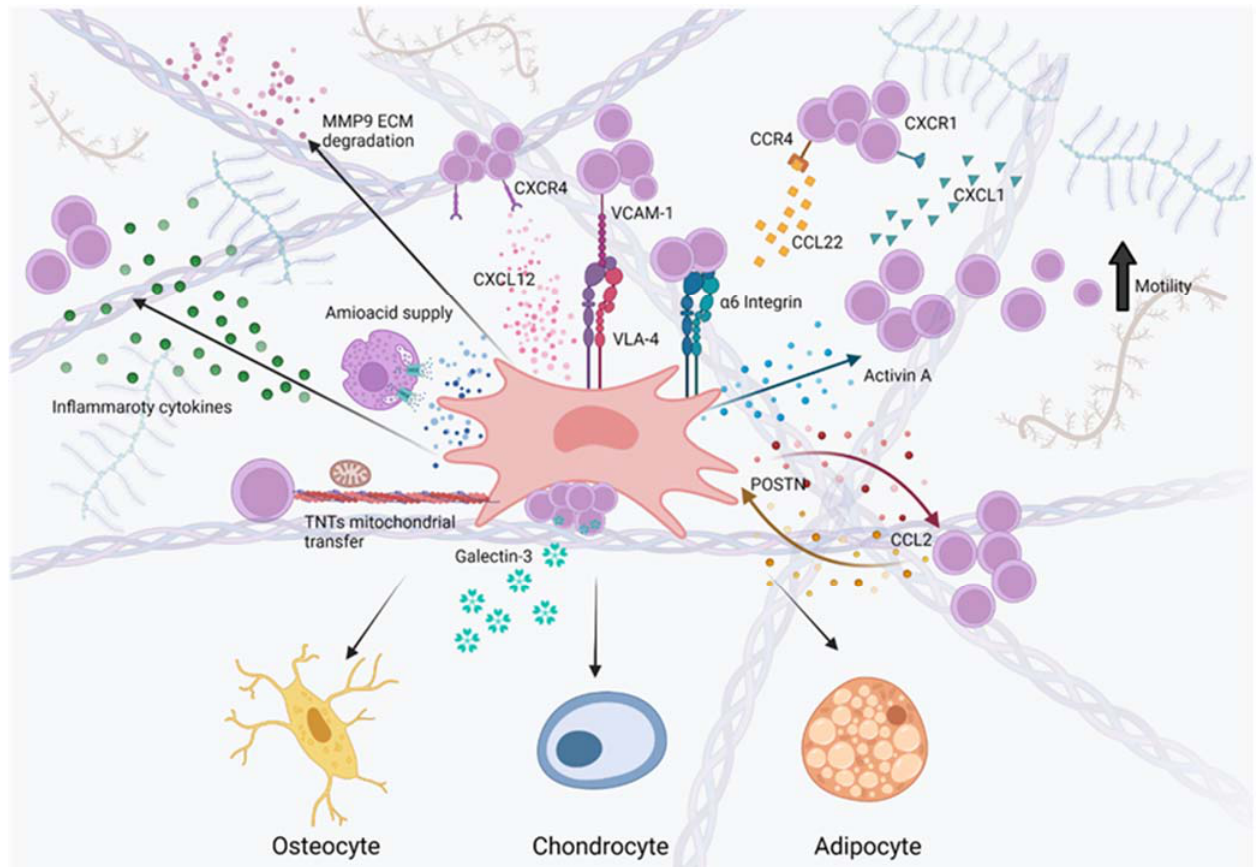
Figure 1. Role of mesenchymal stromal cells (MSCs) within the leukemic bone marrow (BM) niche. MSCs and their progeny including osteocyte/osteoblasts, adipocyte and chondrocyte (bottom) are key elements of B-cell acute lymphoblastic leukemia (B-ALL) BM niche. They interact through different mechanisms with leukemic cells protecting them from chemotherapy and providing signals that promote their survival and proliferation. Within the leukemic niche, MSCs secrete high levels of Activin A potentially promoting the migration of B-ALL cells to extramedullary sites (right, light blue dots). In turn, the high levels of Activin A downmodulate the production of CXCL12, possibly causing the displacement of healthy hematopoiesis in favor of leukemic cells. Other chemokine axes important for leukemia progression are represented by CXCR1/CXCL1 (blue triangles) and CCR4/CCL22 axis (yellow squares), which contribute to the recruitment of B-ALL cells into the BM niche. MSCs also contribute to the definition of the inflammatory environment, found in the leukemic BM niche, by secreting pro-inflammatory cytokines (left, green dots) including interleukin (IL)1 β , tumor necrosis factor (TNF) α and IL6. The inflammatory environment increases the production of matrix metalloproteinases, such as MMP9 (violet dots), which may promote extracellular matrix (ECM) degradation and leukemia dissemination. MSCs also play a key role in protecting leukemic cells from drug-induced amino acid shortage and oxidative stress by providing nutrients such as asparagine (blue dots) and by transferring mitochondria and organelles via tunneling nanotubes (TNTs, left side). MSCs can also promote chemoresistance through cell–cell contact through very late antigen-4 (VLA-4), integrin α 6 and Galectin (Gal)3-dependent pathways. The leukemic BM is characterized by high levels of MSCs-derived periostin (POSTN, right, red dots), which increase the expression of CCL2 (right, yellow dots) by leukemic cells and promote leukemia proliferation and adhesion to MSCs. Consequently, B-ALL-derived CCL2 induces the expression of POSTN, creating a self-reinforcing loop. Created with BioRender.com (accessed on 13 May